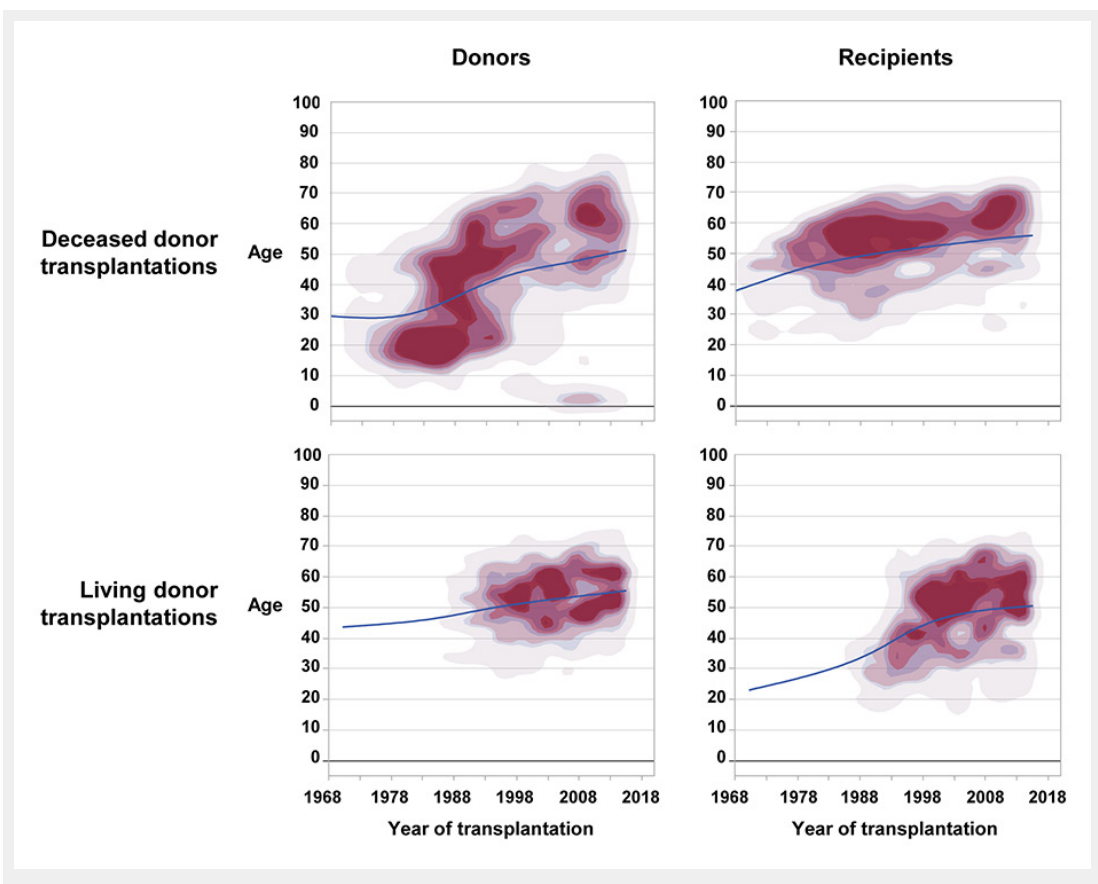
Figure 2 Evolution of age distribution, subdivided into donors and recipients, and grouped according to donor kidney source (living vs deceased). Data are presented as density plots. The darkness of area corresponds to the number of